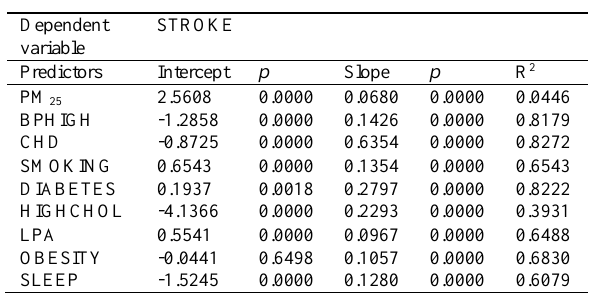
Table 2. Univariate linear regression